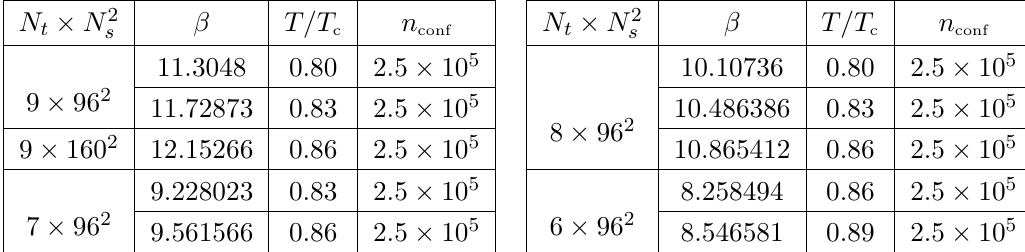
Table 1 . Information on the first set of lattice